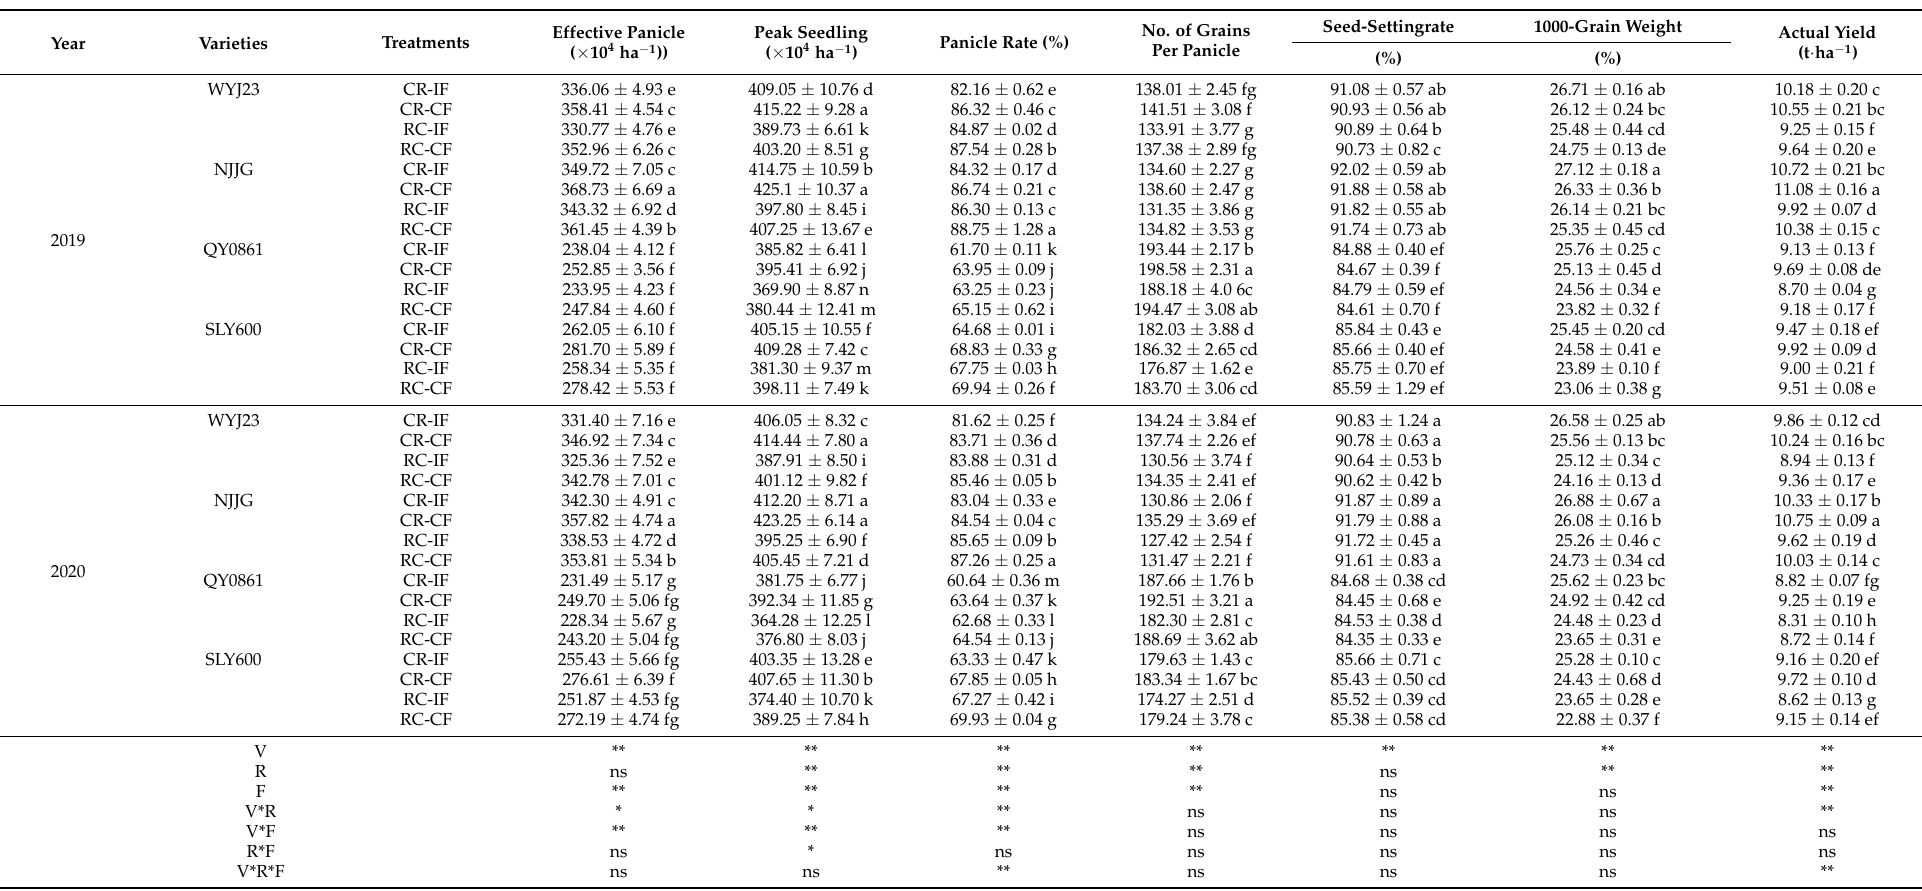
Table 2. Yield and its components in different rice varieties under two types of fertilizer